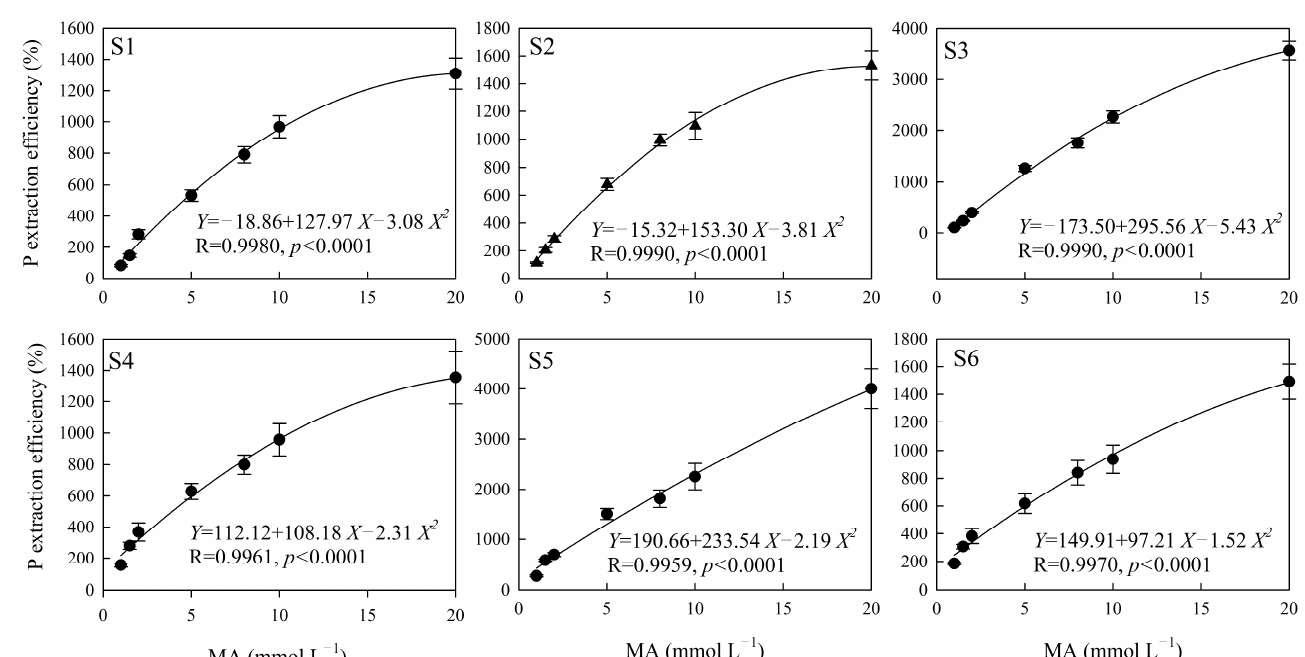
Figure 3. The P extraction efficiency induced by different concentrations of OA. Note: X is the concentration of OA (mmol L − 1 ), Y is the P extraction efficiency of OA (%), R is the correlation coefficient of the fitting equation, and p -value is the significant difference. S1, S2, S3, S4, S5 and S6 are six sampling areas.